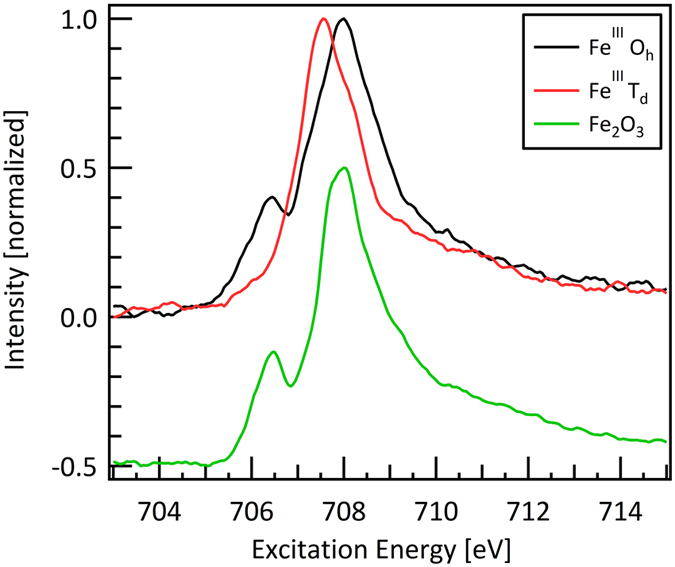
Fe L3-edge of FeIII Oh and FeIII Td species.The two spectra are linear components of the Fe L3-edge spectra of Ni1-y-zFeyCrzOx given in Fig. S2 in the Supplementary Information. The Fe2O3 reference spectrum is taken from22 and shifted downwards by 0.5 for better readability.